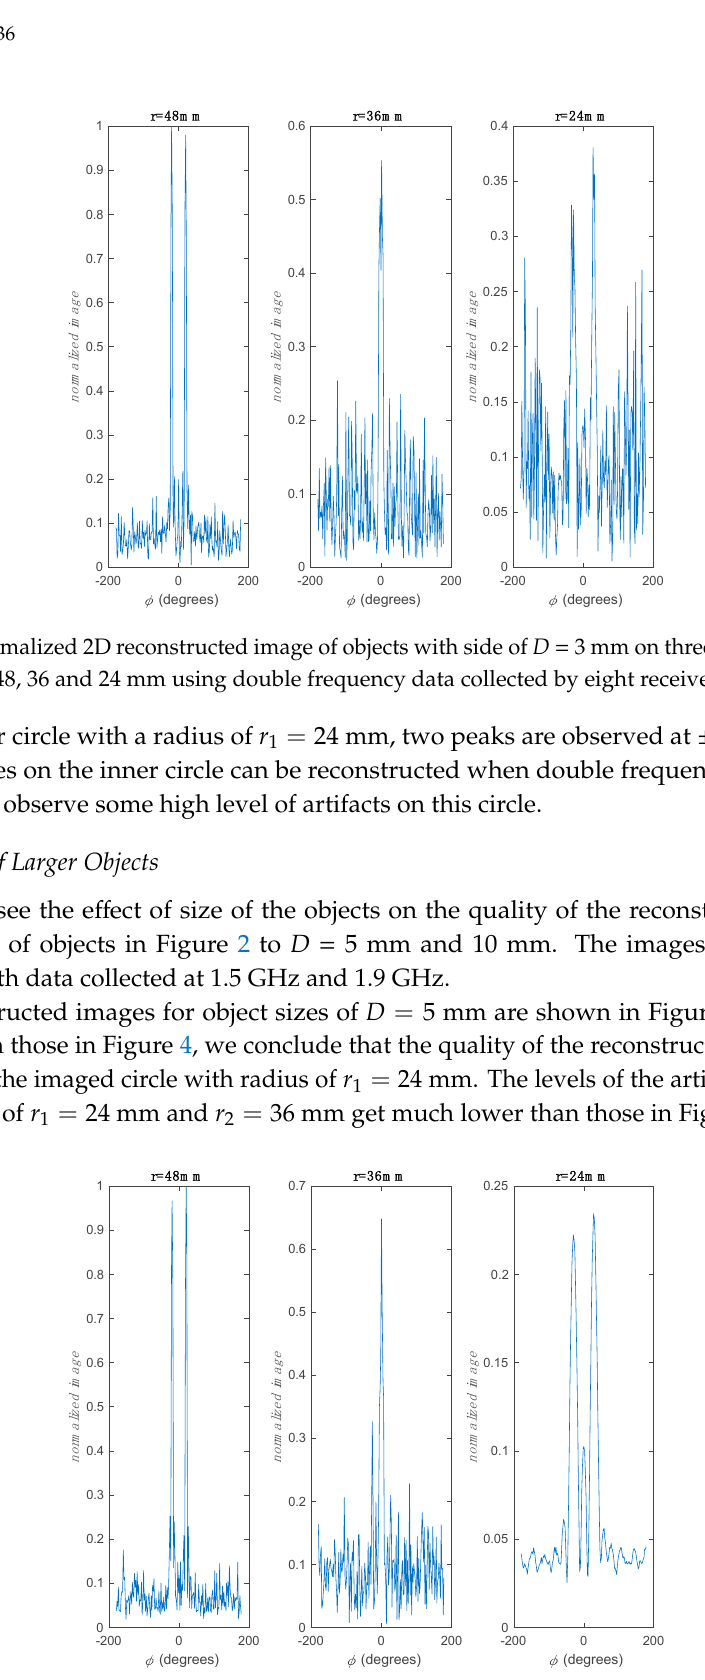
Figure 6. Normalized 2D reconstructed image of objects with a side of D = 10 mm on three imaged circles with radii of 48, 36 and 24 mm using double frequency data collected by eight receiver antennas. Form Tables 1 and 2, it is observed that the quality of the imaging degrades for inner circles. This has been notified in the previous works as well (e.g., see ref. [18]). Also, it is observed that the quality of the imaging improves when using double frequency data compared to single frequency data.